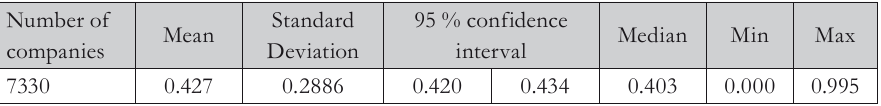
Tab. 1 – Evaluation of the sample – descriptive statistics: the debt ratio. Source: Own investiga- tion.